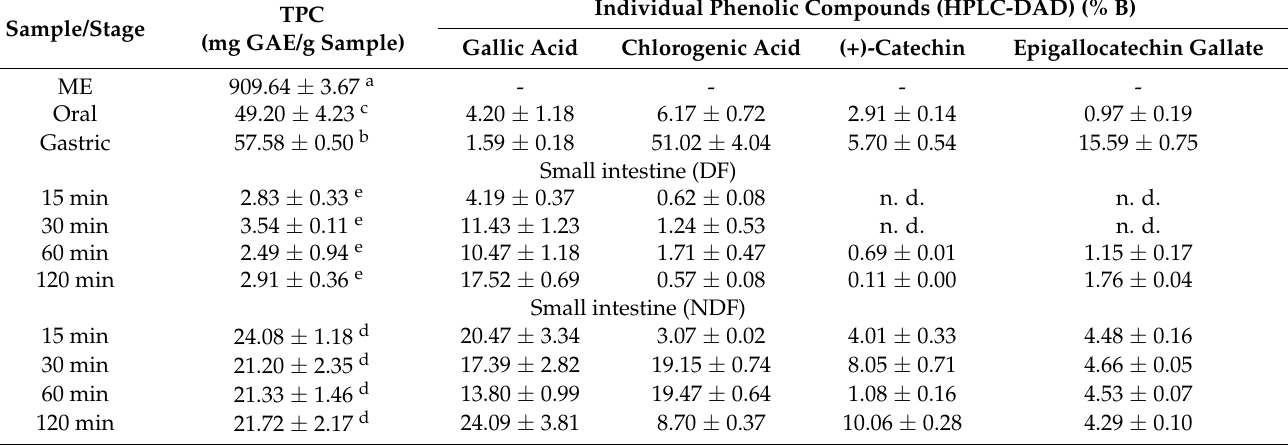
Table 1. The total phenolic compounds from the encapsulated Andean blackberry powders along with the